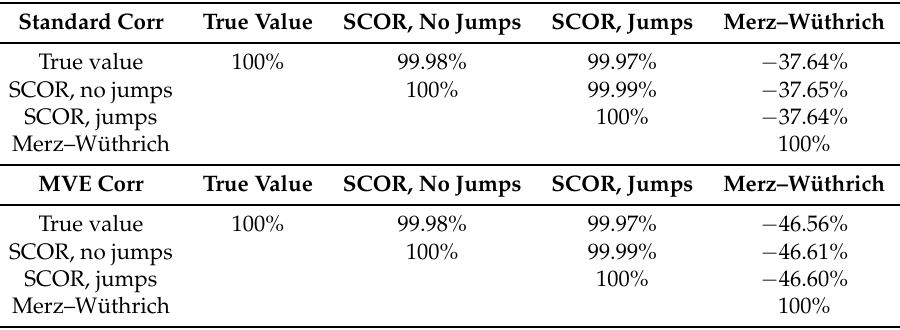
Table 2. Correlation matrix of the different capital measures. Above, the standard correlation estimate and below, the robust “MVE” estimate Rousseeuw and Leroy